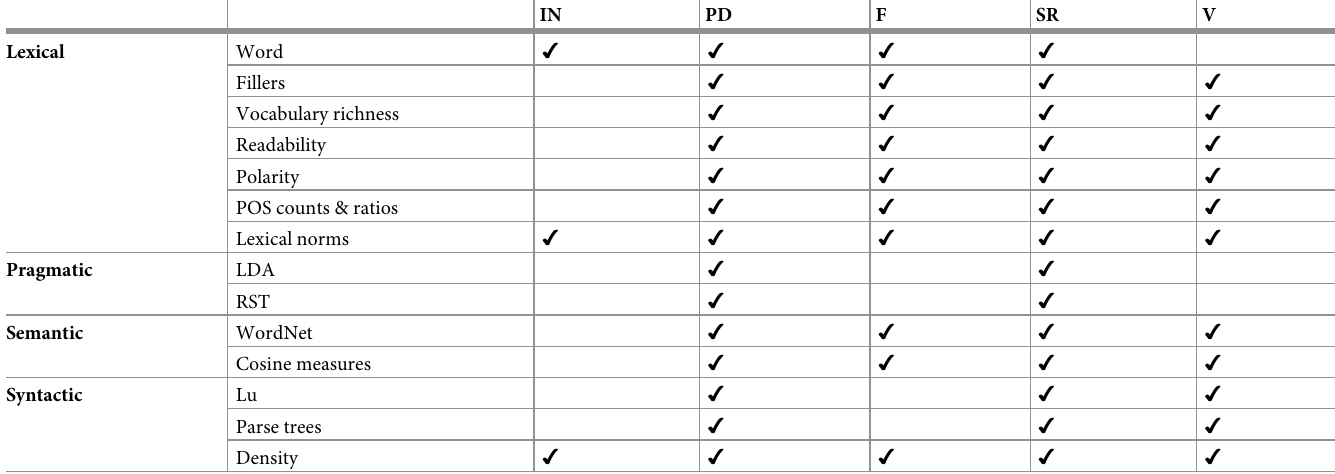
Table 2. Extracted lexical, syntactic, semantic, and pragmatic features for image naming (IN), picture description (PD), fluency (F), story recall (SR), and vocabulary (V) tasks. We do not extract any text features for the Winograd schema or the word-colour Stroop